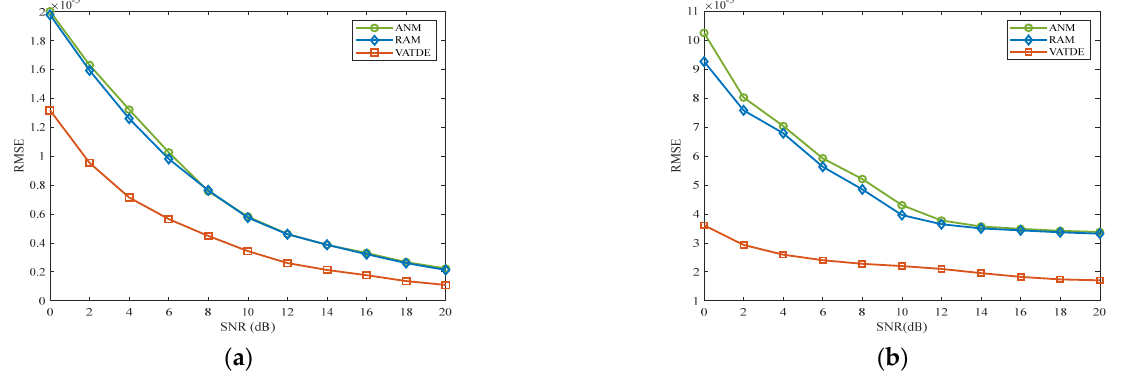
Figure 6. RMSE of time delay estimation. ( a ) Single time delay, ( b ) multiple time delays.